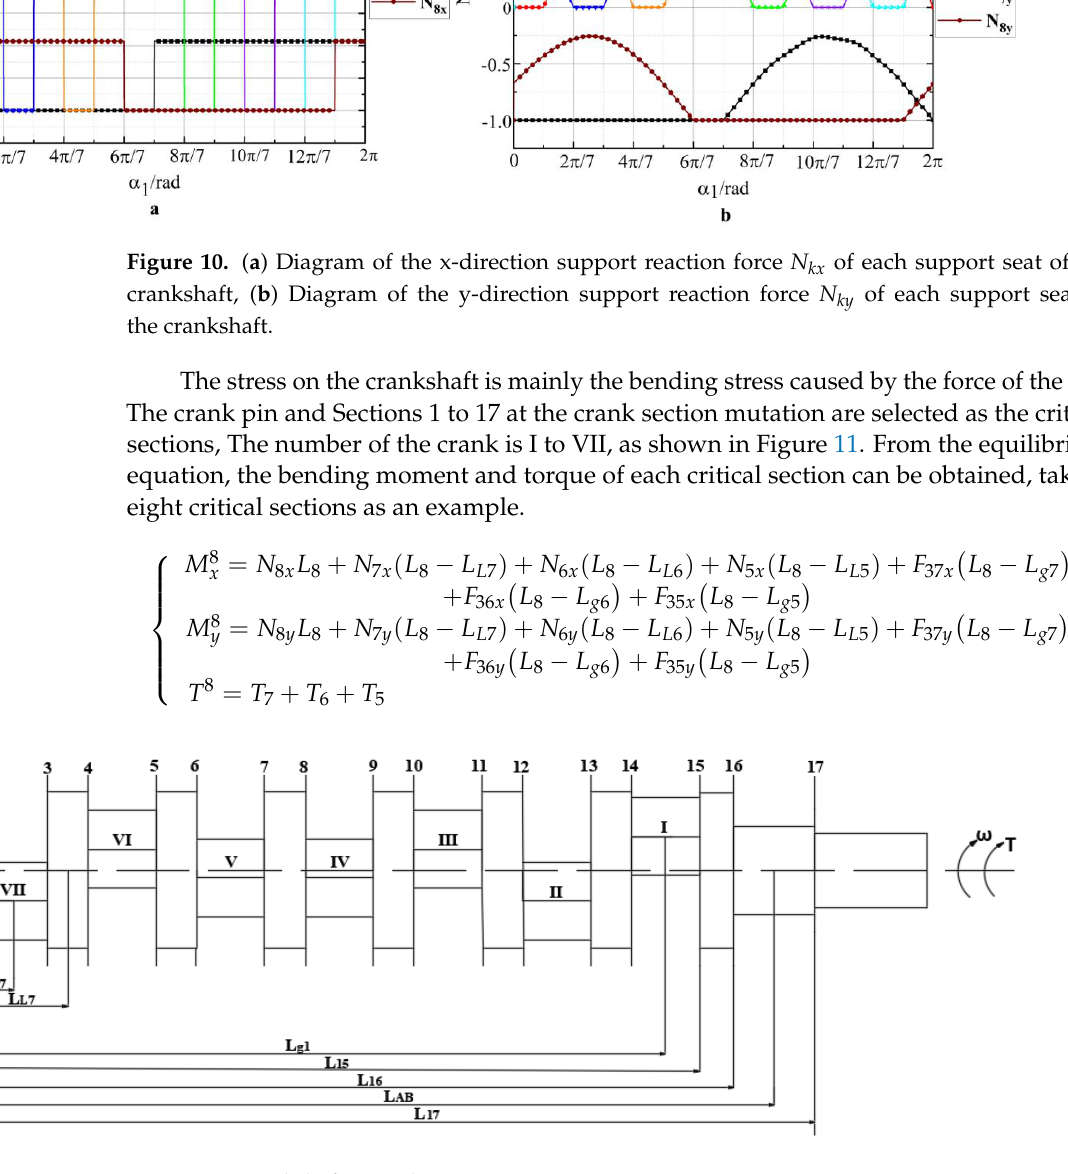
Figure 11. Crankshaft critical sections.